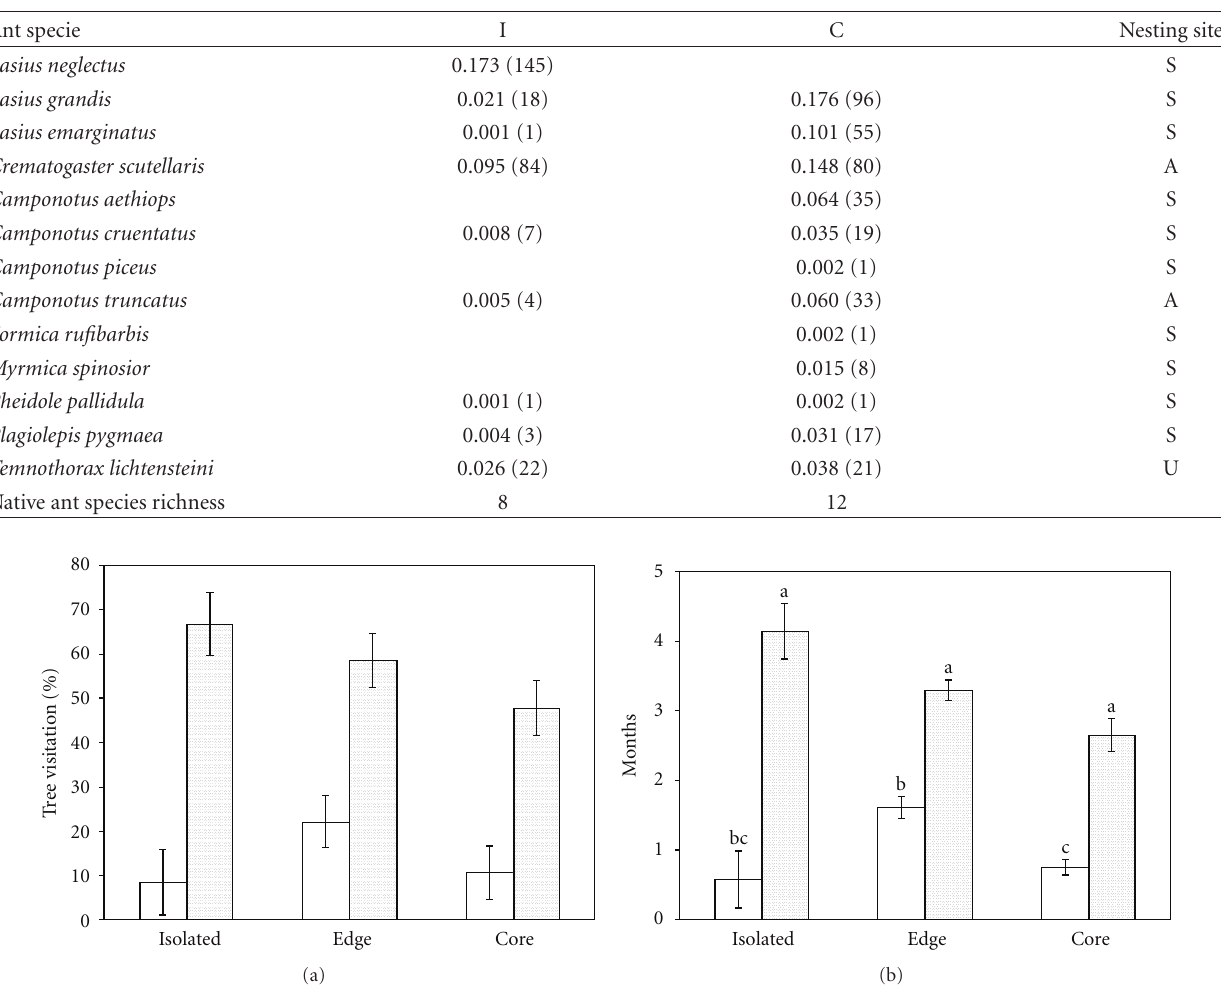
Table 2: Relative frequency (absolute frequency/number of observations) of tree visitation by each ant species at invaded (I) or control (C) forest during the activity period (7 months; in 2006). In brackets are shown absolute frequency that is the number of times each ant species was found along the seven censuses (number of observations: 840 at invaded fragments, 546 at control fragments). Ants were discriminated according to their nesting site: soil (S), arboricolous (A), or arboricolous-under bark (U).